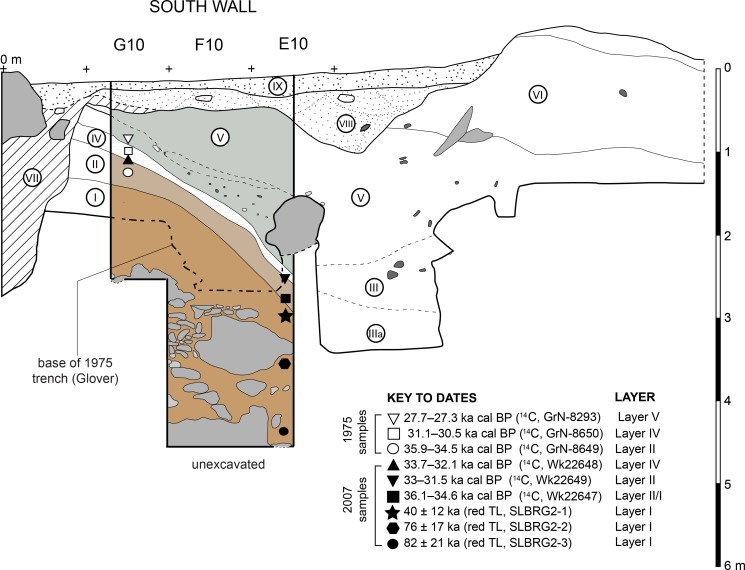
South wall stratigraphic profile at Leang Burung 2 (2007 excavations).Calibrated 14C ages are reported at the 95% confidence interval (see Table 1).The 14C dating results are presented in Table 1. All of the dated shells are Late Pleistocene in age, with two exceptions: a shell from Layer II (spit 48) yielded an unexpectedly young age of 9–8.6 ka cal BP (OZO824), while the suspected intrusive shell from Layer B (spit 58) was similar in age (9.6–9.5 ka cal BP, Wk33233). We regard both shells as having been displaced from stratigraphically higher contexts, most likely during the excavations.